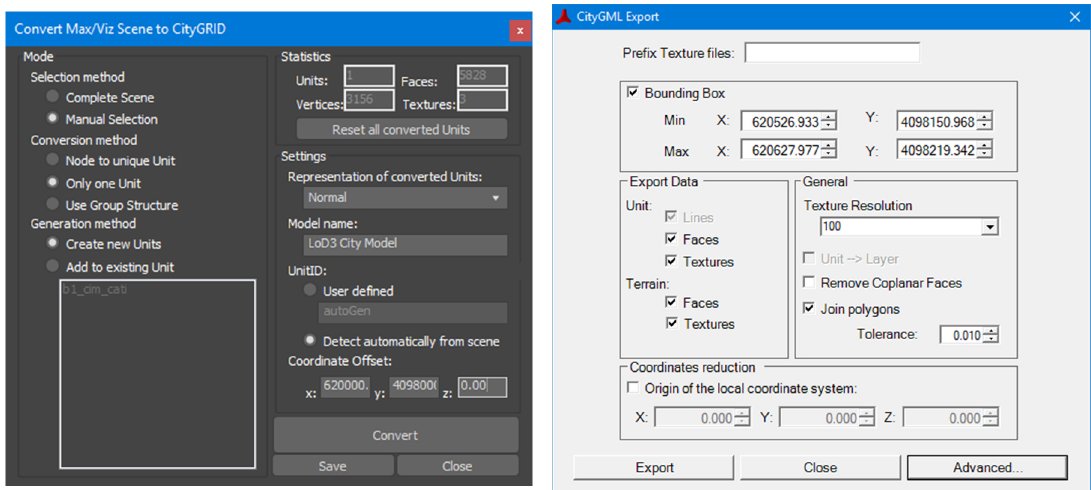
Figure 10. The Binary Large Object (BLOB) conversion parameters ( left ) and CityGML export parameters ( right ).